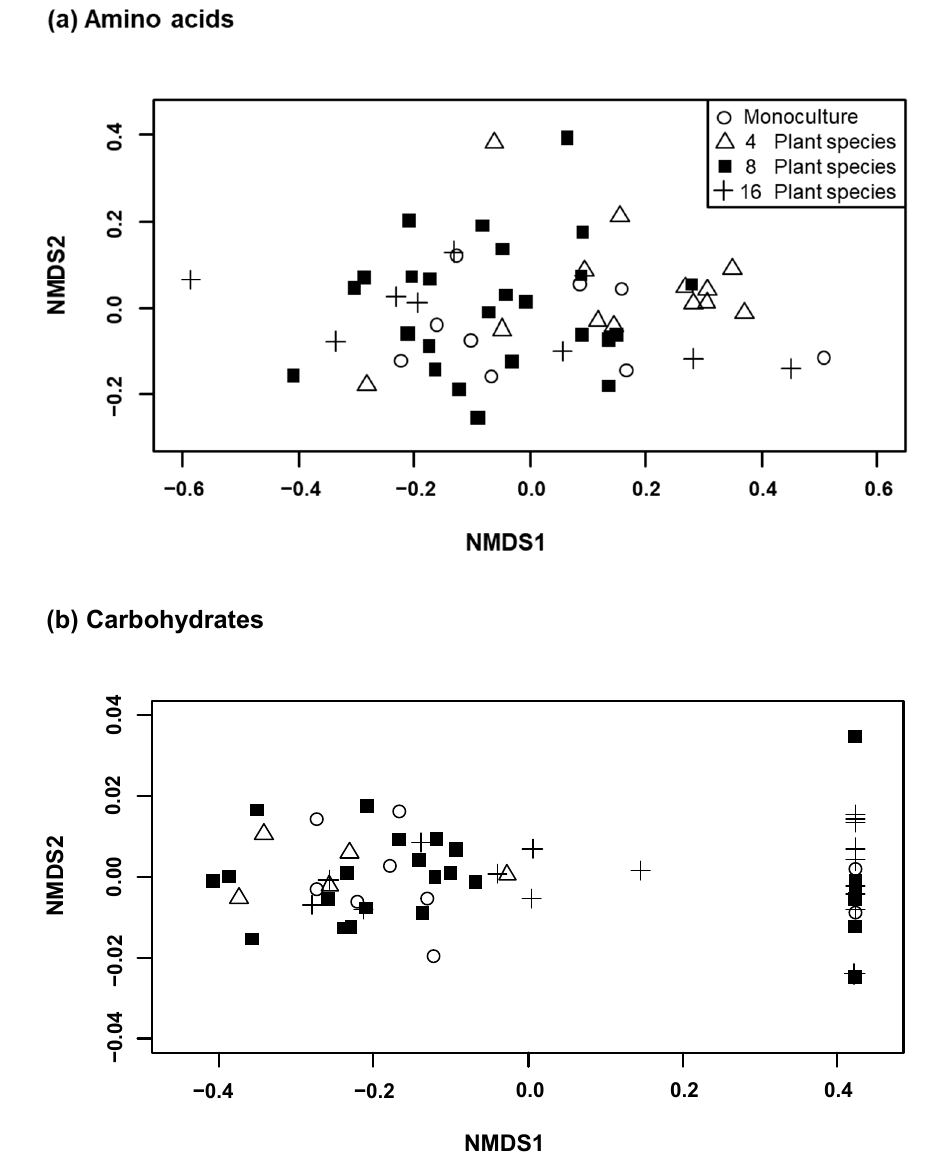
Figure 2. Non-metrical dimensional scaling (NMDS) based on ( a ) proportions of amino acids and ( b ) concentrations of carbohydrates in floral nectar of Knautia arvensis . Each symbol represents a sample of different plant communities: open circles = monoculture, open triangles = four plant species communities, filled black squares = eight plant species communities, and black crosses = 16 plant species communities. Note that all samples accumulating at the right side of the graph lack sucrose, likely because sucrose had already been hydrolyzed to fructose and glucose by yeast and/or bacteria which naturally occur in nectar [63].